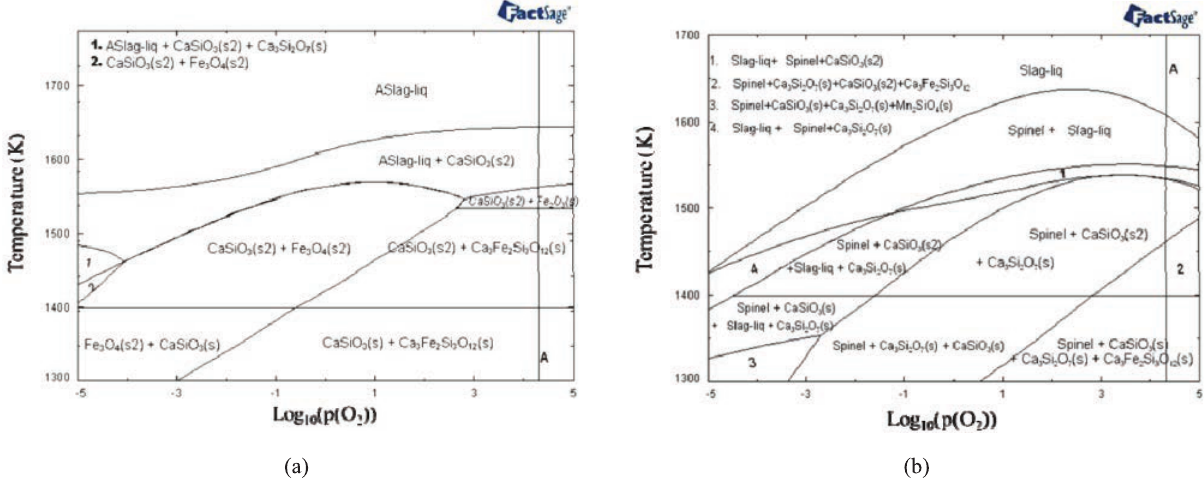
Fig. 1: (a) The phase stability diagram of ternary 37.5 mass% CaO – 25 mass% FeO – 37.5 mass% SiO 2 slag system, (b) The phase stability diagram of quaternary 27.5 mass% CaO – 30 mass% FeO – 27.5 mass% SiO A line marked A corresponds to the partial pressure of oxygen in air. P(O